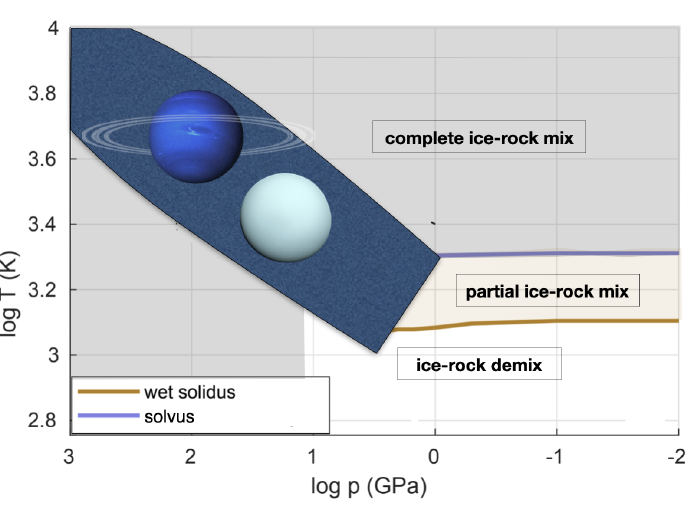
Figure 7. Ice–rock interaction regimes in pressure–temperature space, adopted from [143], with the area relevant for interiors of Uranus and Neptune marked in blue. The marked regime for Uranus and Neptune is the range of possible ice and rock distribution in Uranus and Neptune interiors, based on various structure and evolution